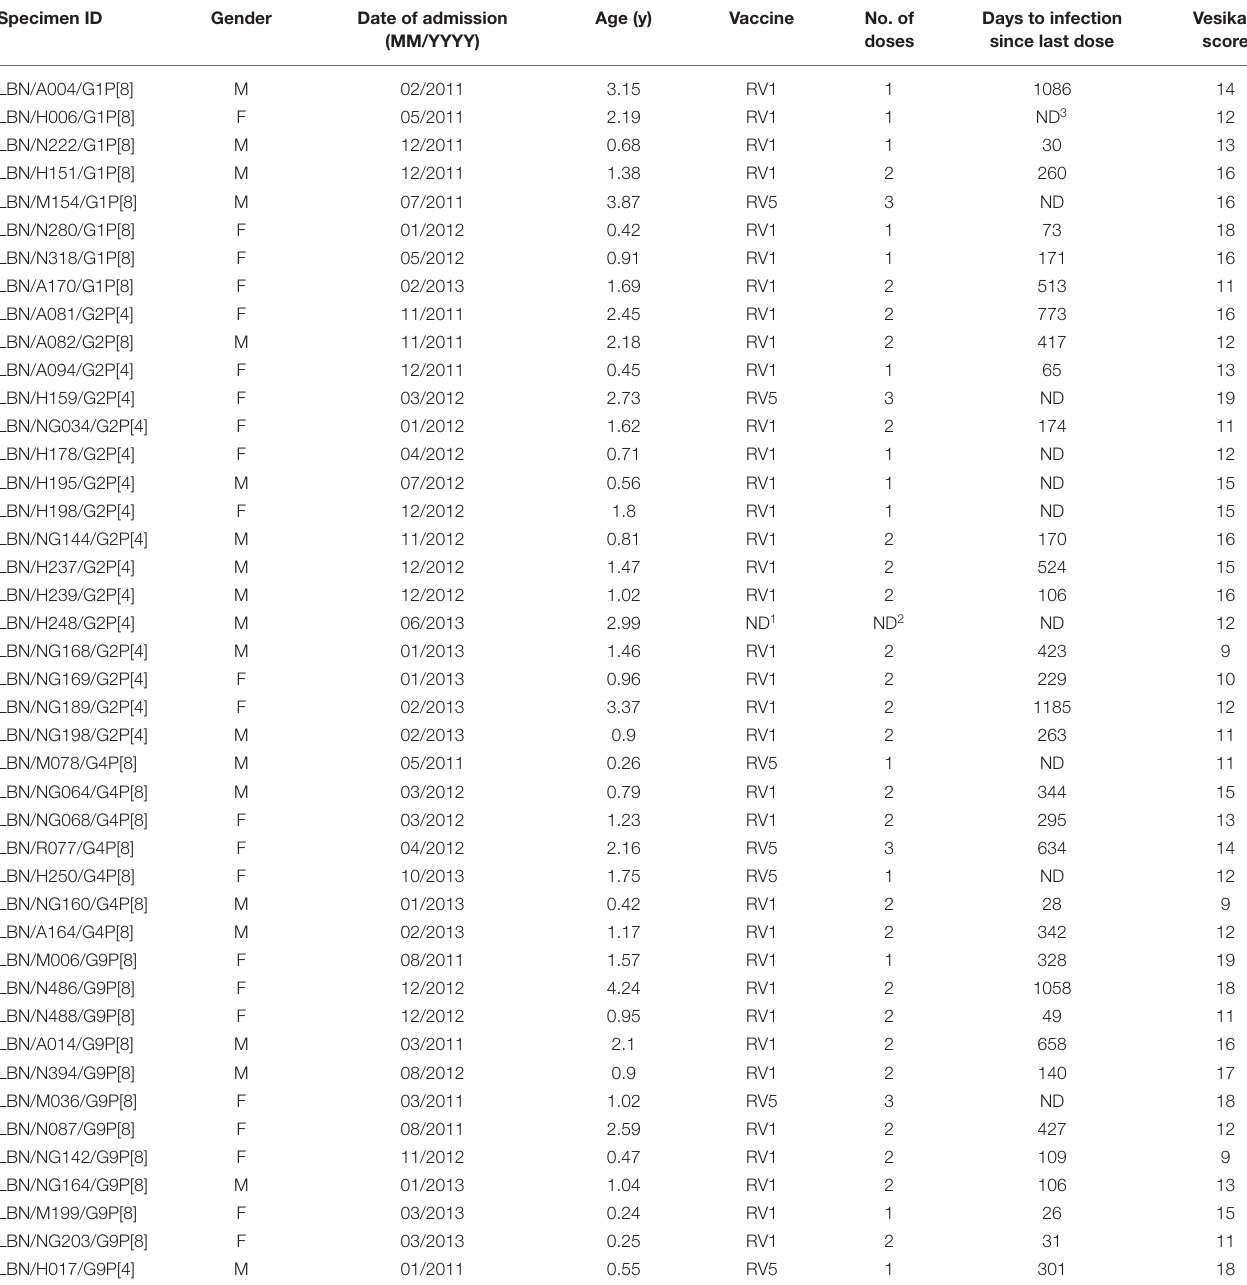
TABLE 1 | Demographics, RVA vaccination, and the clinical score of Lebanese breakthrough cases included in this study. Specimen